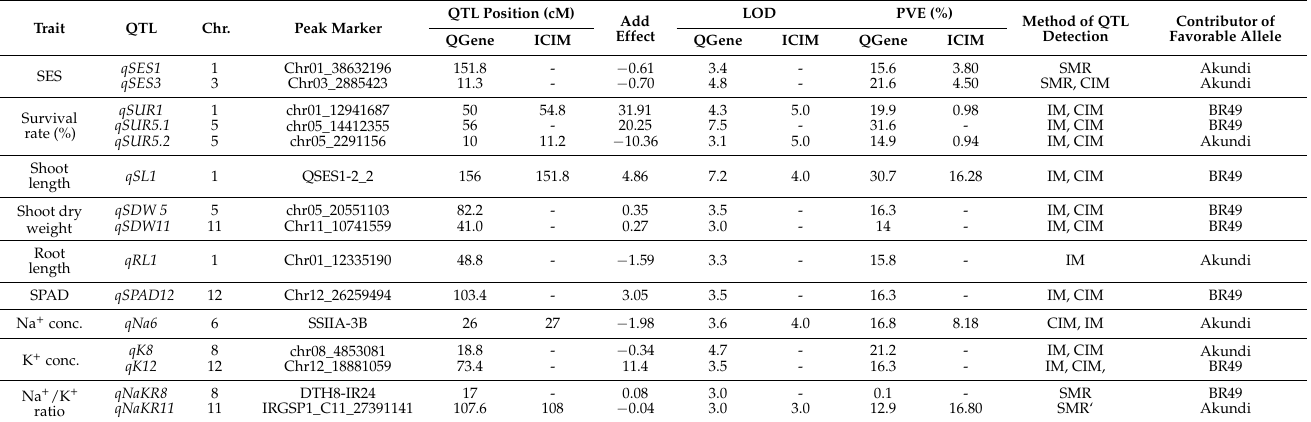
Figure 3. A genetic linkage map of 12 chromosomes was constructed using 884 SNP markers. This genetic map shows the distribution of detected QTLs on seven different chromosomes of rice. The map was built based on selected individuals of an F 2:3 population of a cross between BR49 and Akundi. The number at the top of each linkage group indicates the chromosome number. The names of the SNP markers are shown on the right, and the rectangular boxes beside SNPs represent the approximate locations of the QTL identified for salt tolerance. Table 2. Locations and features of QTLs detected for seedling-stage salt-tolerance-related agronomic and physiological